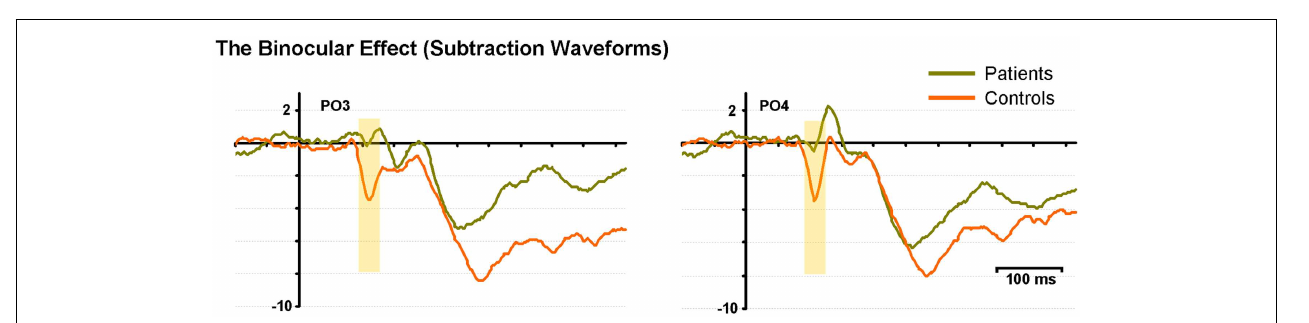
FIGURE 3 |The binocular effect is characterized with difference waveforms (SUM minus BASE) for controls (red) and patients (green) at two representative electrodes (PO3 and PO4) .The yellow shading denotes the early “binocular effect”